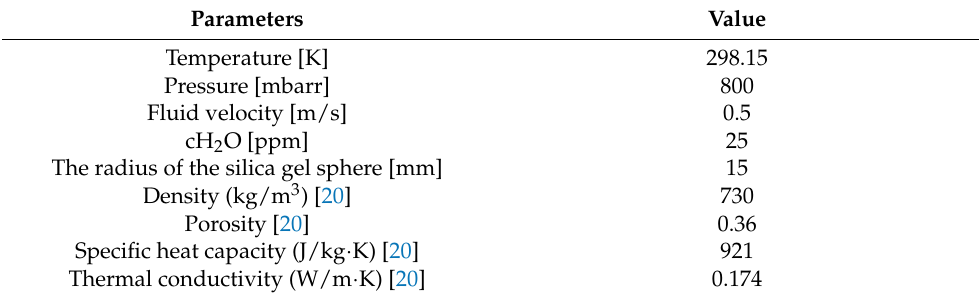
Table 1. Parameters used in the 3D model simulation.